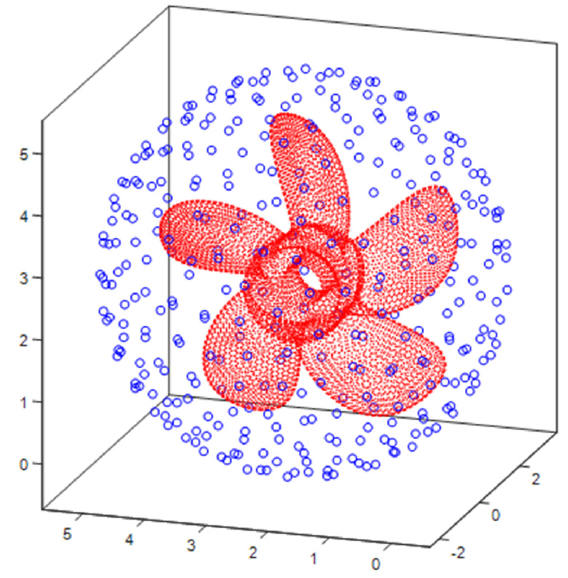
Figure 11. Geometry of the problem ( a ) and the distribution of the shifted Gauss–Lobatto nodes ( b ).